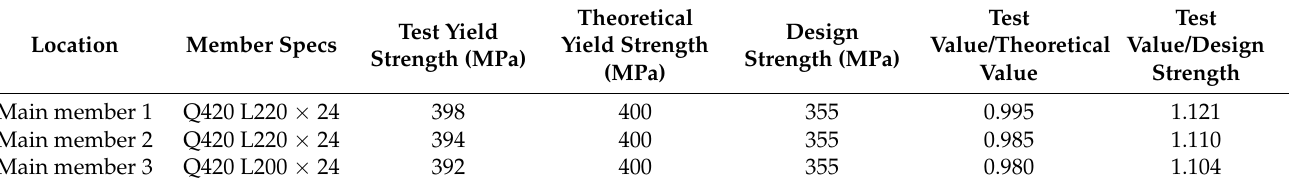
Figure 9. Tower failure. Table 6. Material